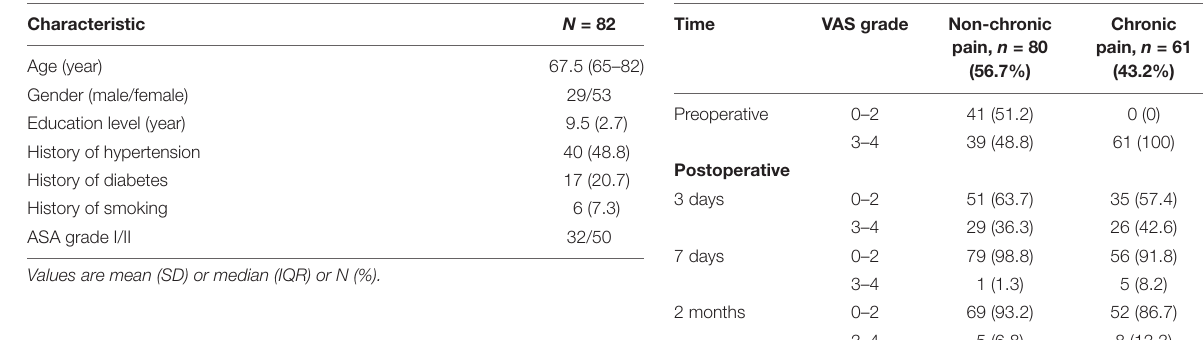
TABLE 2 | General characteristics of the community people not receiving surgery. TABLE 3 | VAS scores of the